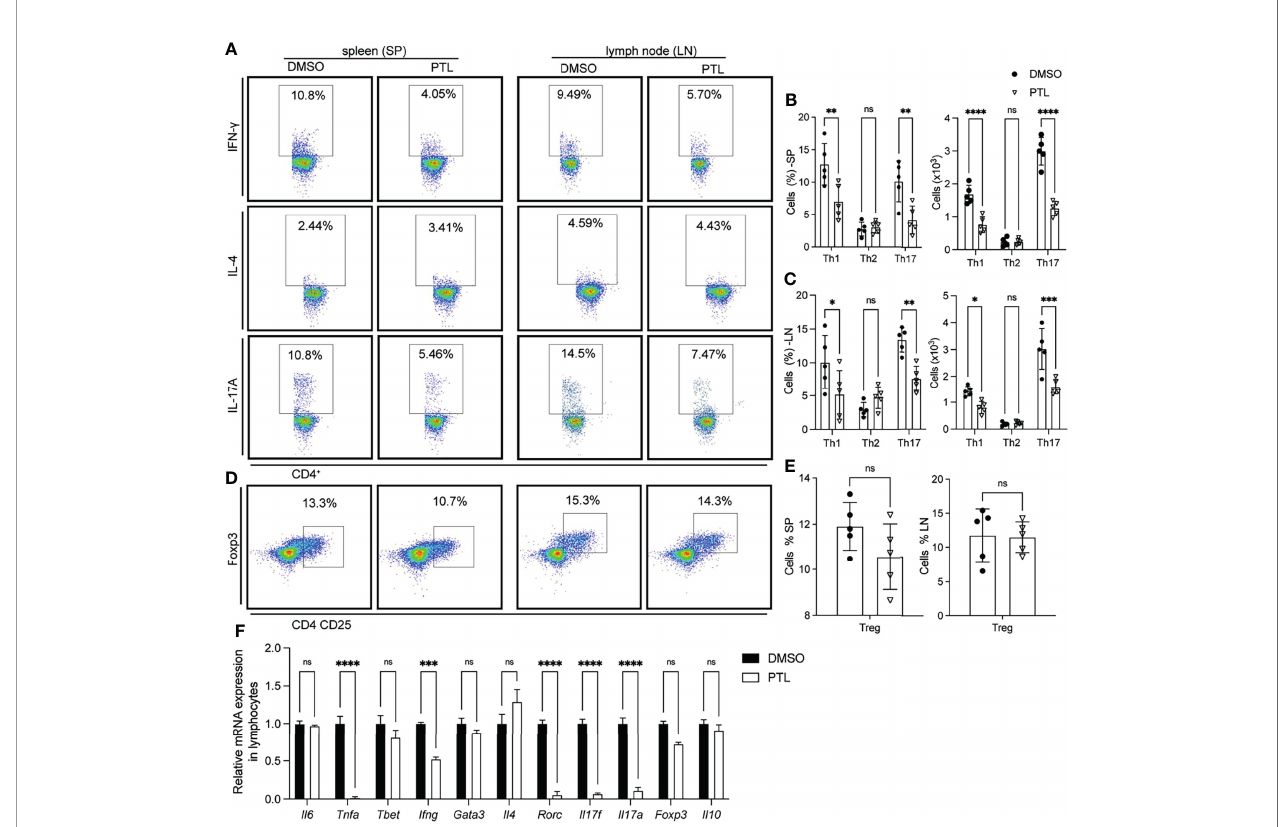
FIGURE 3 | PTL inhibited Th1 and Th17 response in peripheral immune organs of EAE mice. Cells were isolated from the spleen (left) or lymph node (right) of EAE mice treated with DMSO or PTL ( n = 6) on day 12 after the immunizations and stimulated with or without PMA/ion plus golgi stop for 5 h (A) Percentage of Th1 (represented by IFN- g ), Th2 (represented by IL-4), and Th17 (represented by IL-17A) in spleens and lymph node of two groups of EAE mice. (B) Statistical analysis of Th1, Th2, and Th17 cell numbers in spleens of two groups of EAE mice. (C) Statistical analysis of Th1, Th2, and Th17 cell numbers in lymph nodes of two groups of EAE mice. (D) Percentage of Tregs from spleen (left) and lymph node (right) of two groups of EAE mice. (E) Statistical analysis of Tregs number in spleen and lymph node. (F) RT-PCR analysis of mRNA expression of Th1, Th2, Th17, and Treg cell-related cytokines, transcription factors, and surface receptors in CD4 + T cells separated from spleen of two groups of EAE mice ( n = 3) on day 13 after the immunizations. Data shown are representative of 3 independent experiments. The error bars shown were the mean ± SD. * p < 0.05, ** p < 0.01, ***p < 0.005, ****p < 0.001 using unpaired Student ’ s t -test. ns means “ not signi fi cant ”